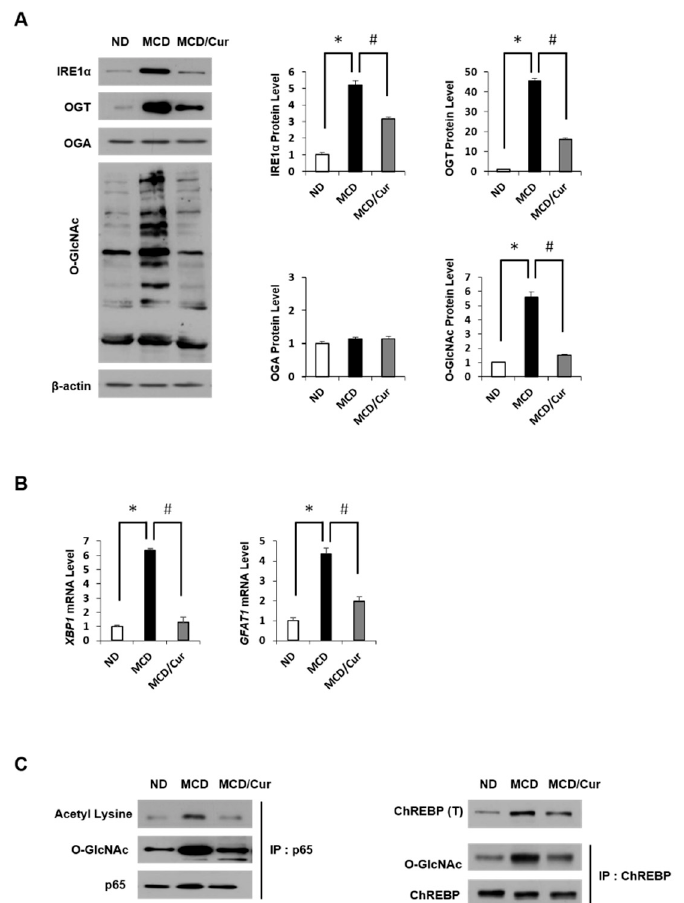
Figure 4. O -GlcNAcylation and the proteins associated with HBP . ( A ) Hepatic expression levels of inositol requiring enzyme 1 α (IRE1 α ), O -GlcNAc transferase (OGT), O -GlcNAcase (OGA) and total O -GlcNAcylated proteins by immunoblot analysis in ND, MCD diet, or MCD/curcumin (100 mg/kg) diet mice. In the graphs, the intensity of proteins was determined by densitometry. Data were obtained from three times of independent experiments. ( B ) The levels of protein expression associated with the hexosamine biosynthetic pathway (HBP) were determined by qRT-PCR analysis. The levels of X-box binding protein 1 ( XBP1 ) and glutamine:fructose-6-phosphate amidotransferase ( GFAT1 ) mRNAs are shown as fold increase. Gene expression levels were normalized to 18s rRNA as an internal standard, and the data are presented as the means ± SD ( n = 7 / group). * p < 0.05 vs. ND diet group, and # p < 0.05 vs. MCD diet group. ( C ) The left panel shows that p65 immunoprecipitates were immunoblotted against acetyl lysine and O -GlcNAc, separately. Similarly, on the right panel, hepatic expression levels of ChREBP were measured, and ChREBP was also immunoprecipitated and then immunoblotted against O